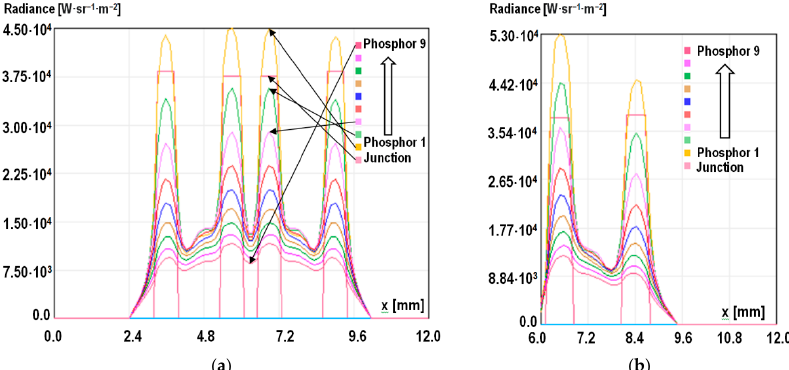
Figure 25. Simulated distributions of the temperature rise (model setup: 400 mA driving current, 25 °C ambient temperature, light propagation described by model g) presented in Section 5.1, with equal blue and yellow absorption, 90% importance level) ( a ) surface temperatures: full model; ( b ) cross-sectional plots of temperature distributions at the blue chip junctions and at the top surface along the green lines; ( c ) surface temperatures: half model.